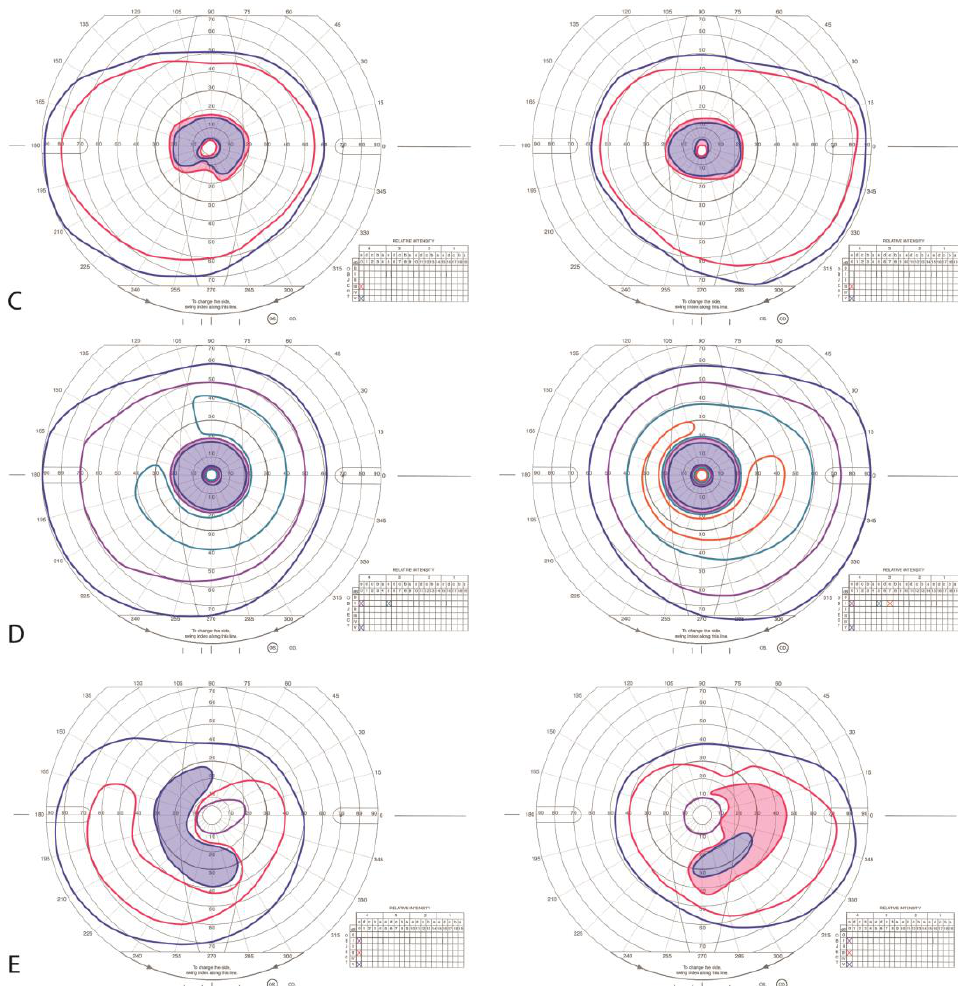
Figure 2. Kinetic Perimetry. ( A ) Goldmann kinetic perimetry of II:1 at age 52 shows extensive mid-peripheral ring scotomas with preserved central islands; ( B ) Visual fields at age 60 show large central scotomas without central islands; ( C , D ) Goldmann kinetic perimetry of II:3 at age 47 and 51, respectively, shows progressive expansion of mid-peripheral ring scotomas and preserved central islands; ( E ). Goldmann kinetic perimetry of II:4 at age 56 shows mid-peripheral ring scotomas with preserved central islands. Left panels show left visual fields while right panels show right visual fields. Shaded regions indicate